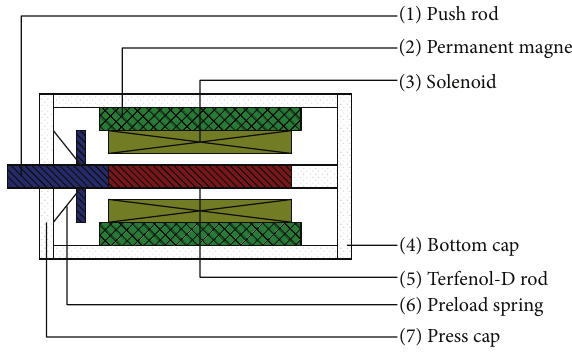
Figure 1: Section view of GMA.